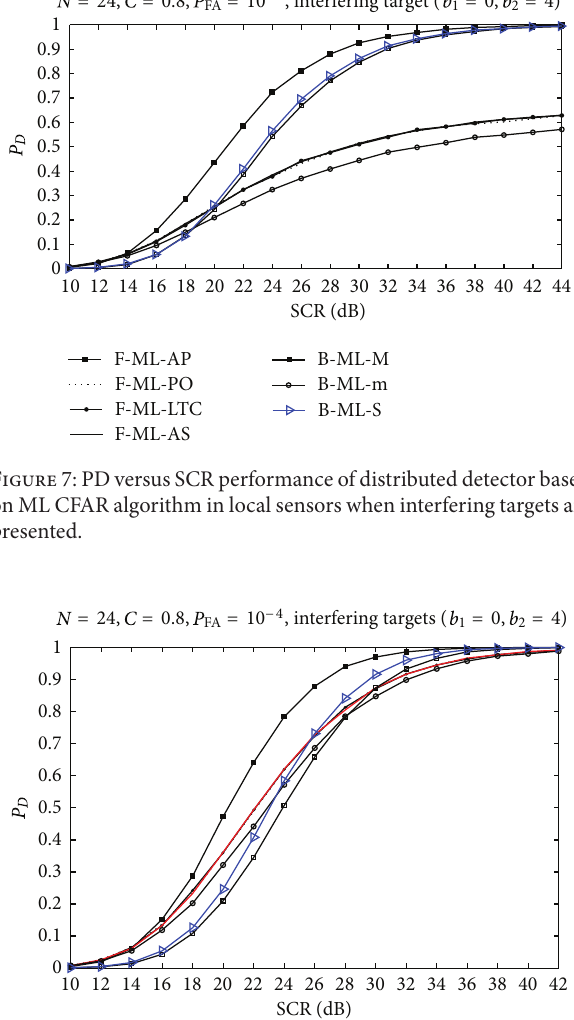
dB. F 8: PD versus SCR performance of distributed detector based on OS CFAR algorithm in local sensors when interfering targets are 1 = 20